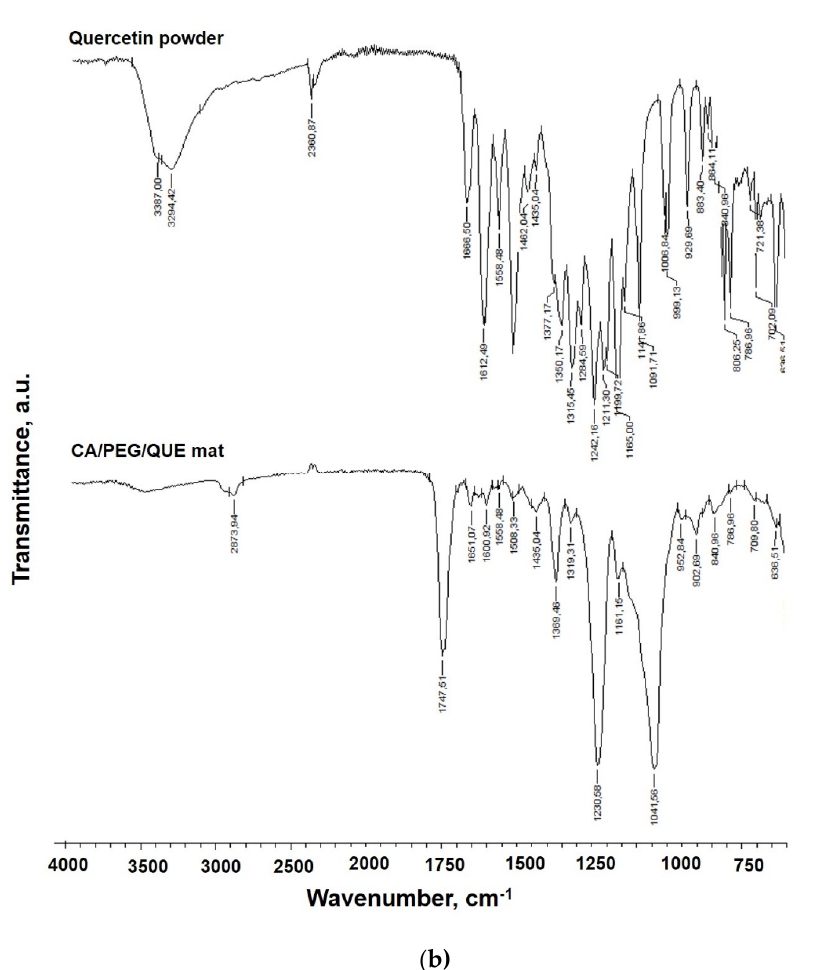
Figure 2. IR spectra of: ( a ) CA and CA / PEG and ( b ) CA / PEG / QUE fibers and quercetin (powder).